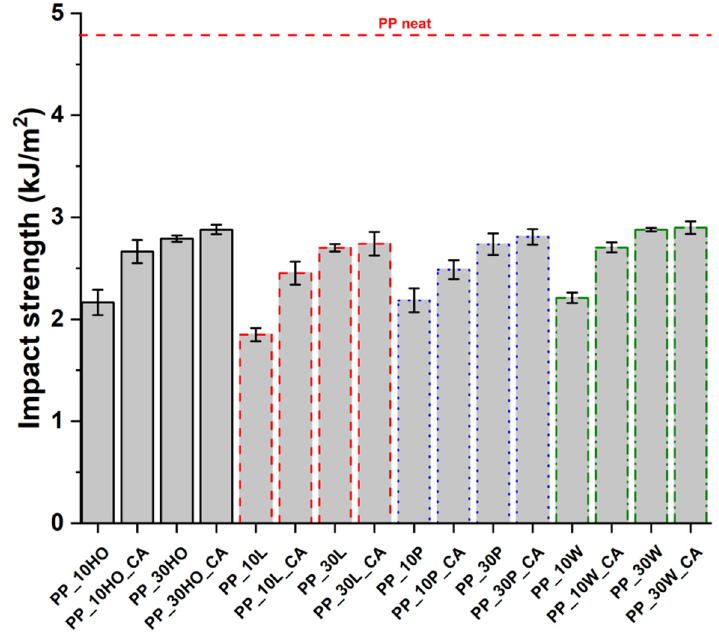
Figure 18. The results of Charpy impact tests for PP-based composites.